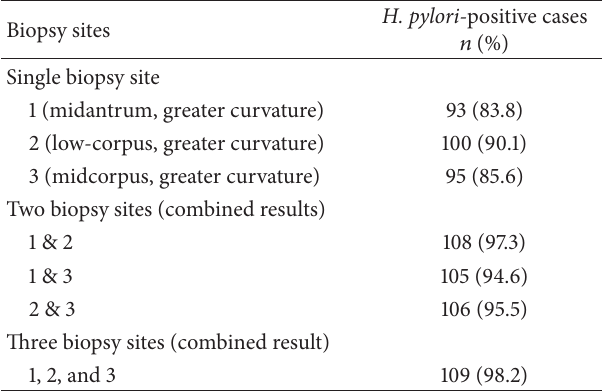
Table 4: RUT results with specimens taken from different biopsy